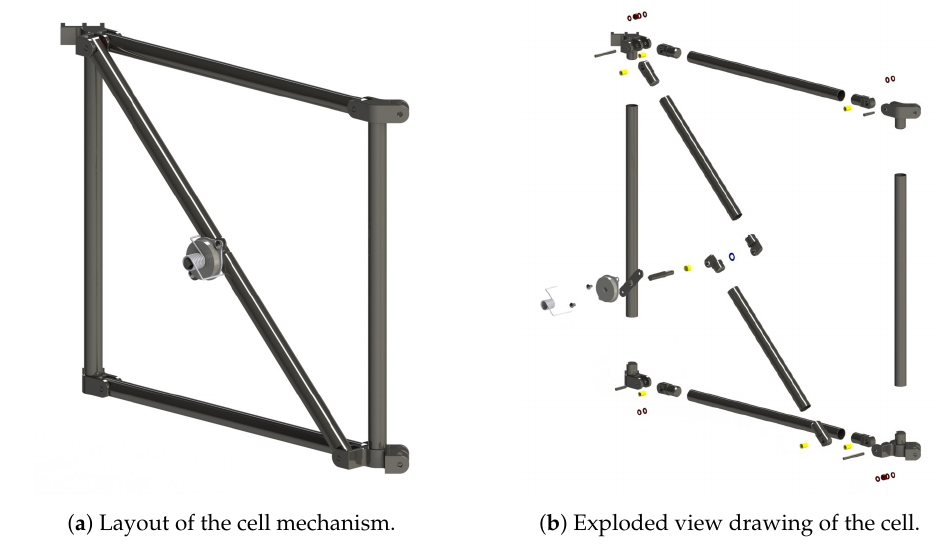
Figure 5. Views of the proposed cell